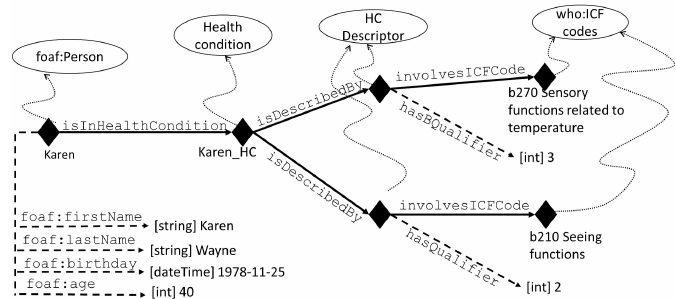
Figure 3. The modelling of a passenger with FOAF and ICF. Individuals are represented with diamonds, full line arrows indicate object-type properties, dashed line arrows indicate datatype properties, curved dotted lines state the type of an